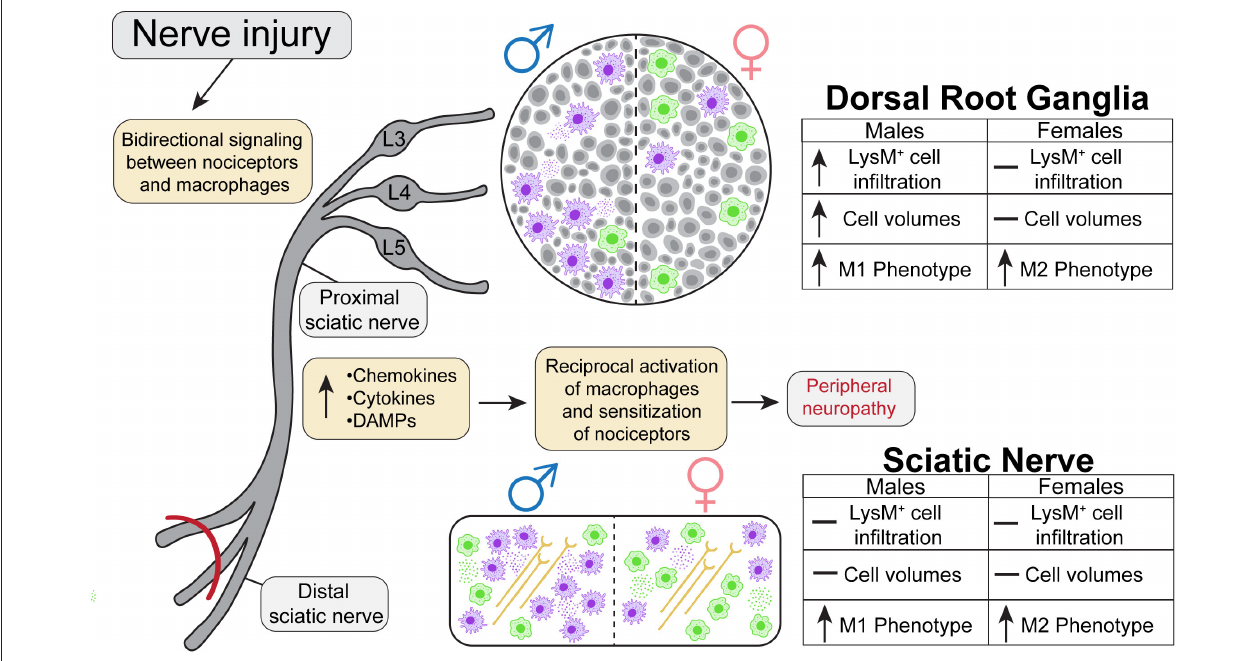
FIGURE 6 | Graphical abstract representing the dynamic nature of macrophage recruitment and morphological changes following SNI in males and